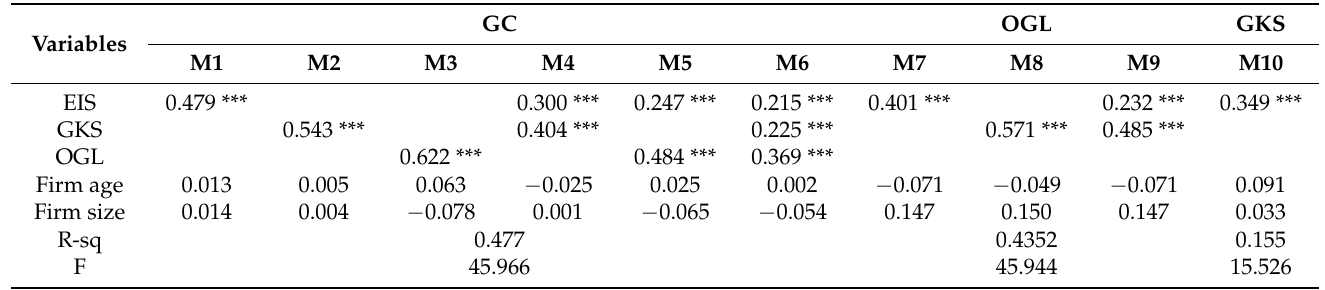
Table 4. Analysis of regression.